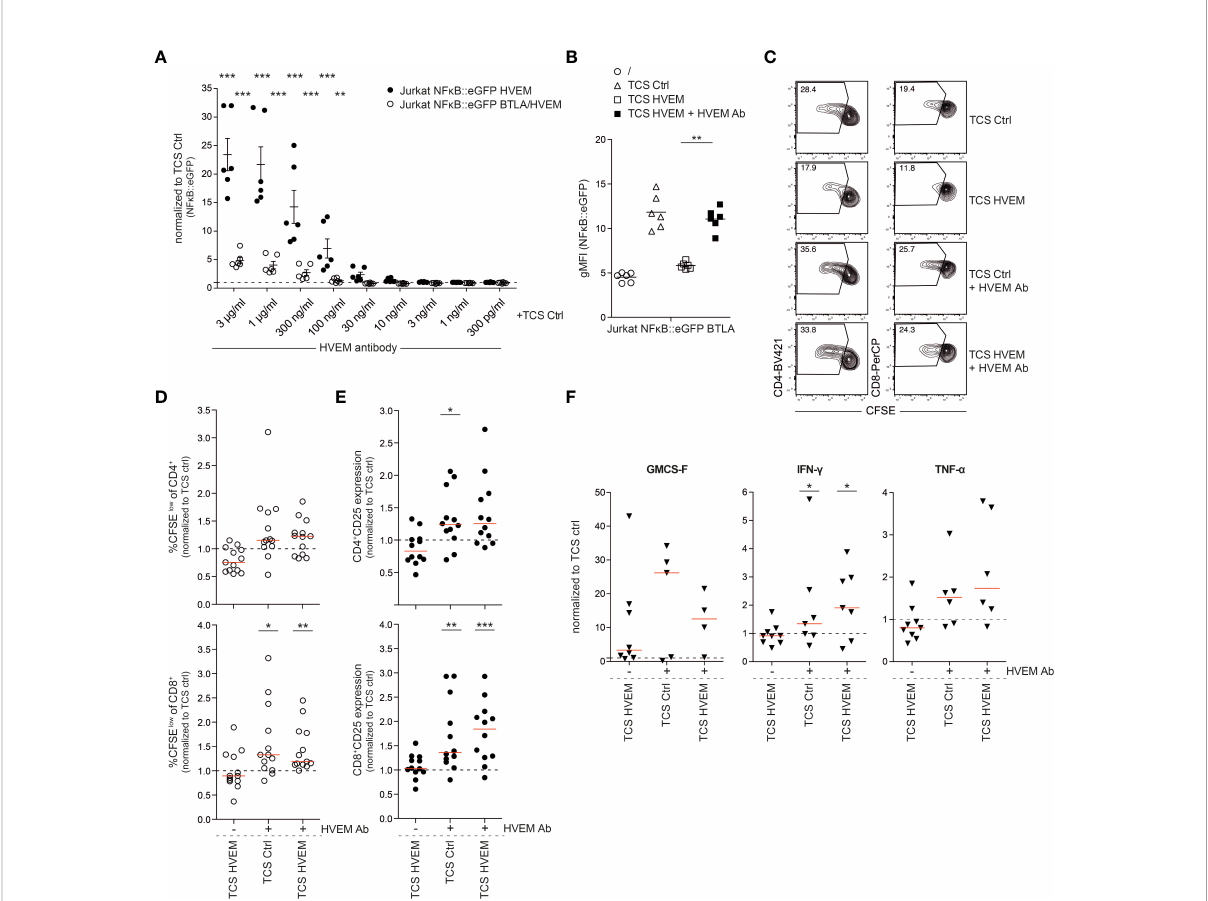
FIGURE 7 Effect of an HVEM antibody on HVEM co-stimulation. (A) HVEM and BTLA/HVEM expressing reporter cells were co-cultured with TCS ctrl in the absence or presence of an HVEM antibody (AF356; R&D systems) at the indicated concentrations. Data of three independent experiments in duplicates is shown. Normalized reporter activation is depicted (gMFI reporter gene expression induced by the indicated TCS or antibody/gMFI reporter gene expression induced by TCS-ctrl stimulated cells). Mean ± D SEM is shown. For statistical evaluation, two-way ANOVA followed by Bonferroni ’ s test was performed (***p ≤ 0.001; **p ≤ 0.01). (B) BTLA expressing reporter cells were left unstimulated or were co-cultured with TCS ctrl, TCS HVEM or TCS HVEM in presence of HVEM antibody (AF356). Three experiments in duplicate and median are shown. For statistical evaluation, a one-way ANOVA with Dunn ’ s multiple-comparisons test was performed (**p ≤ 0.01). (C) Representative contour plots of CFSE- labelled PBMCs stimulated with TCS ctrl, TCS ctrl + HVEM antibody and TCS HVEM + HVEM antibody for 5 days. Percentages of proliferated (CFSE low ) CD4 + and CD8 + T cells are shown. (D, E) CFSE-labelled PBMCs from healthy donors were stimulated for 5 days with the indicated TCS cells. Proliferation (CFSE low ) and activation (CD25 expression) of gated CD4 + and CD8 + T cells was measured at day 5. Data is normalized